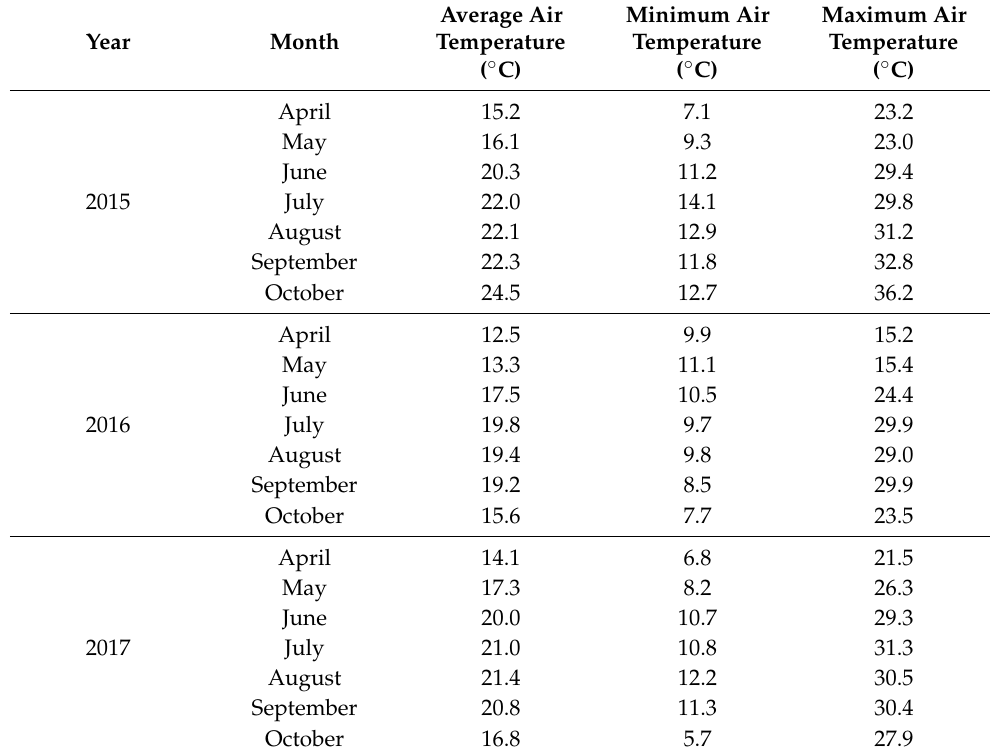
Table 2. Monthly average air temperature, minimum, maximum air temperature, and maximum air temperature for Oakville, California (USA) CIMIS station 77 during the 2015, 2016, and 2017 growing seasons. Intermittent missing climate data from the CIMIS station was pulled from historical regional weather records using the Weather Underground Weather Station